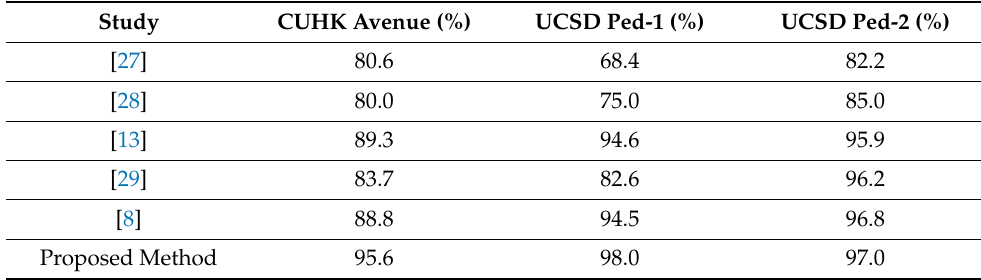
Table 2. Comparison of proposed method with baseline techniques based on